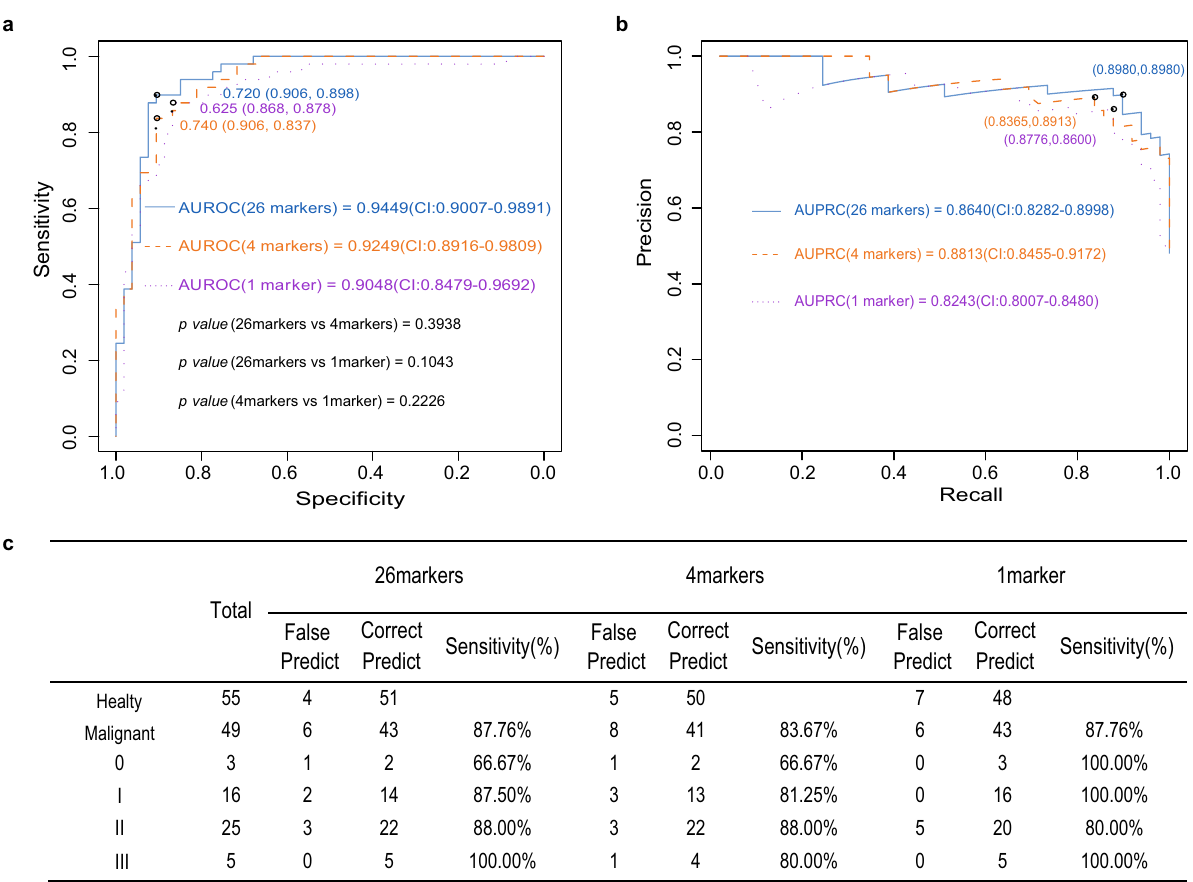
Fig. 4 cfDNA methylation analysis for BC diagnosis in an independent testing cohort. a , b Receiver operating characteristic (ROC) curves and the precision – recall curve (PRC) with associated areas under the curves (AUCs) of the diagnostic prediction model using methylation analysis of different combined markers (top 1, 4, and 26 markers) in the independent testing cohorts. c For different stages, the top 1, 4, and 26 markers model yielded relatively consistent